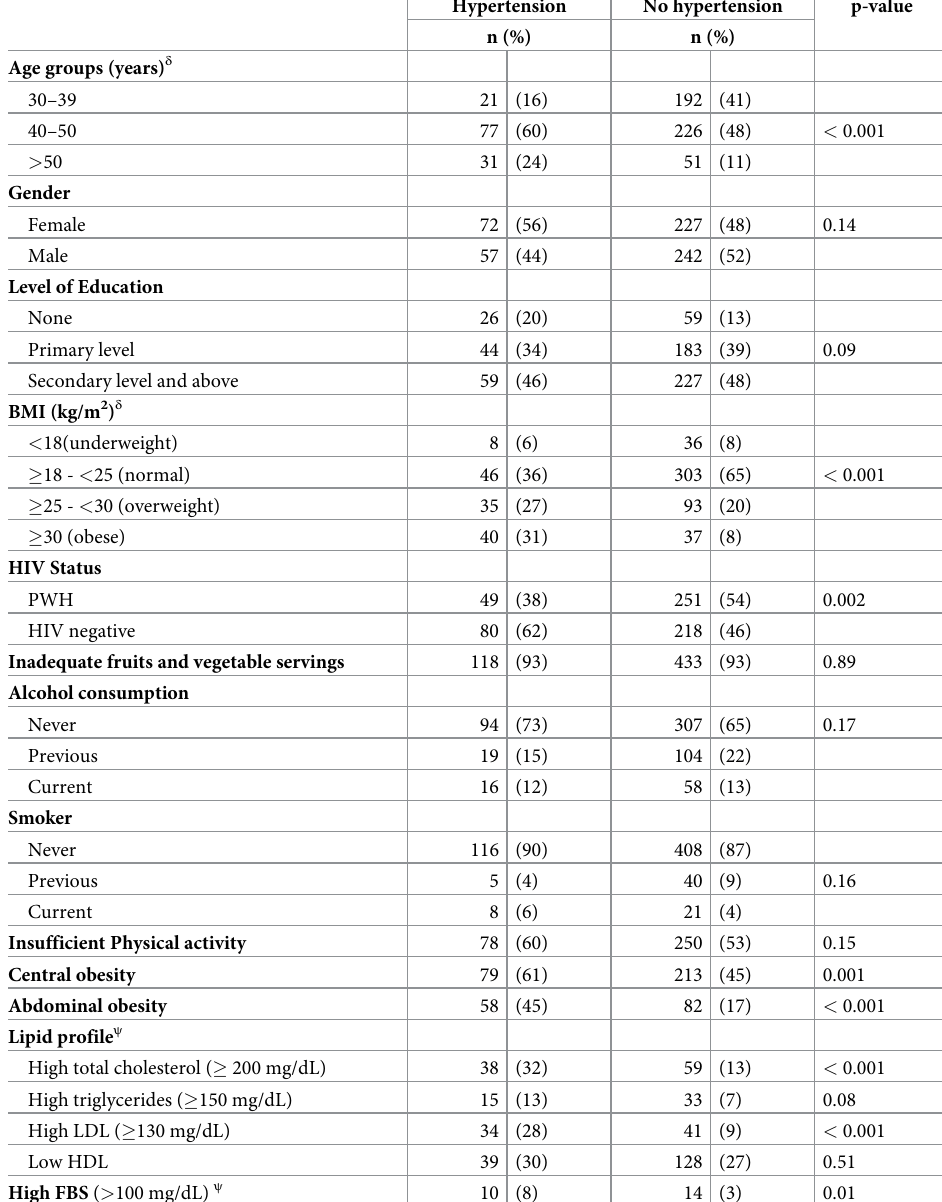
Table 2. Characteristics of participants stratified by hypertension status †